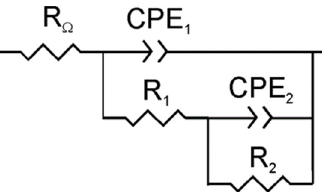
Figure 5. Electrical equivalent circuit (EEC) employed to model EIS data.